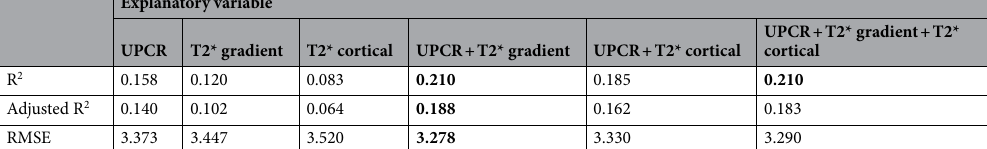
Table 4. Results of multiple regression analysis of the slope of eGFR. The best value is indicated by bold. Multiple regression analysis was used for the slope of eGFR. UPCR urinary protein:creatinine ratio, RMSE root mean square error. Objective variable: eGFR slope. All explanatory variables were adjusted for age and